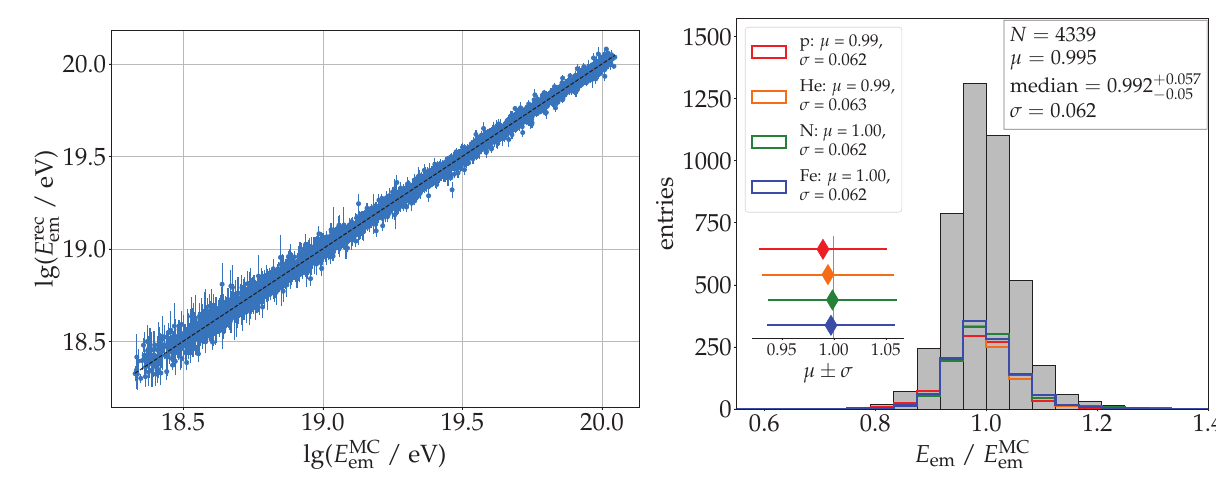
Figure 6. Left: Reconstructed electromagnetic energy versus Monte Carlo true electromagnetic energy as expected for the Auger Radio Detector. Right: Histograms illustrating the performance of the energy reconstruction for the whole simulation set as well as the subsets for di ff erent primary particle types.